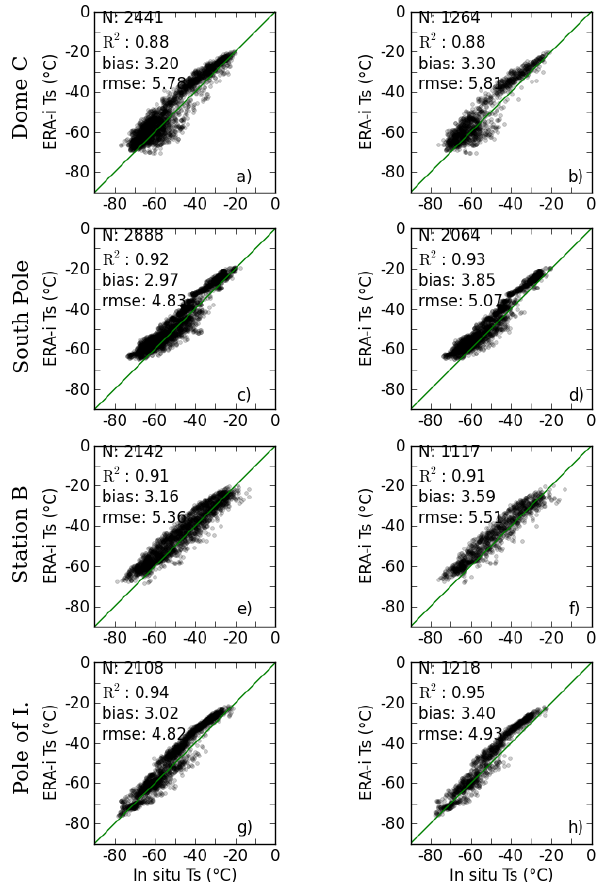
Figure 5. Comparisons of ERA-i T s and in situ T s at (a) Dome C, (c) South Pole, (e) Plateau Station B and (g) Pole of Inaccessibility. Same comparisons but only when MODIS T s values are available at the same time: (b) Dome C, (d) South Pole, (f) Plateau Station B and (h) Pole of Inaccessibility. The green line represents the 1:1 line.